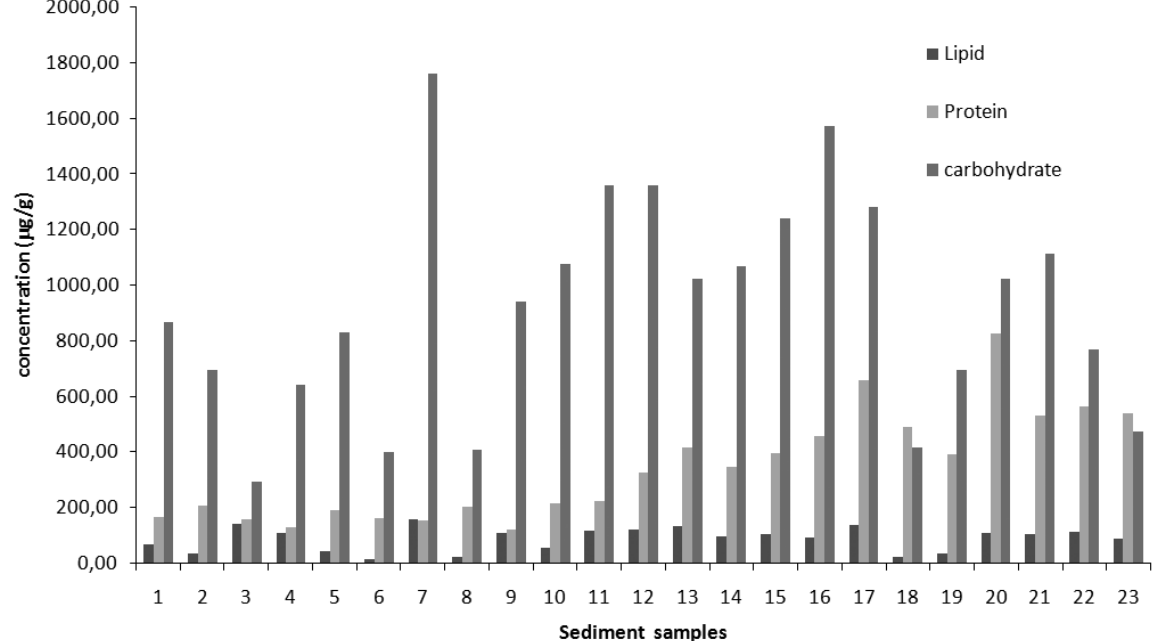
Fig. 4 – Total biopolymer concentrations in the studied samples (lipids, proteins and